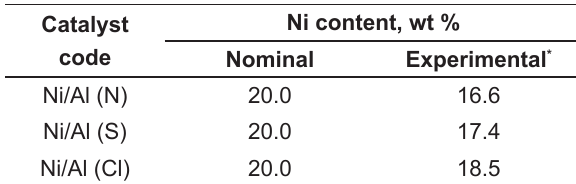
Table 1. Contents of nickel metal precipitated by an impregnation-co-precipitation method using different anion